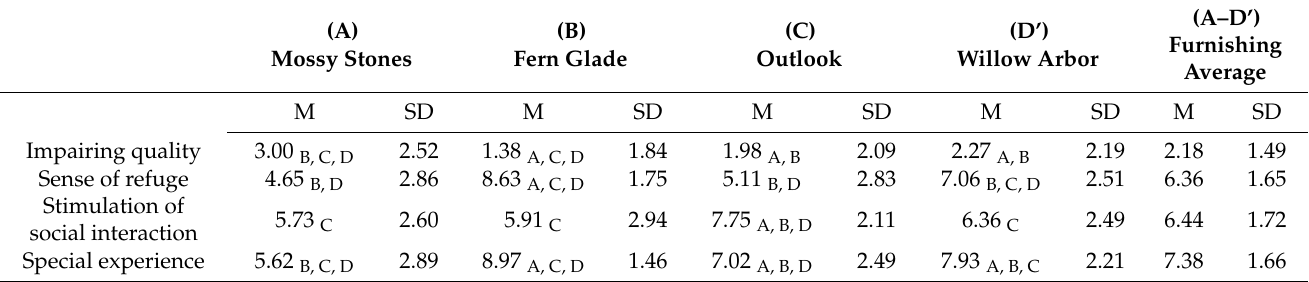
Table 4. Ratings of the furniture at the